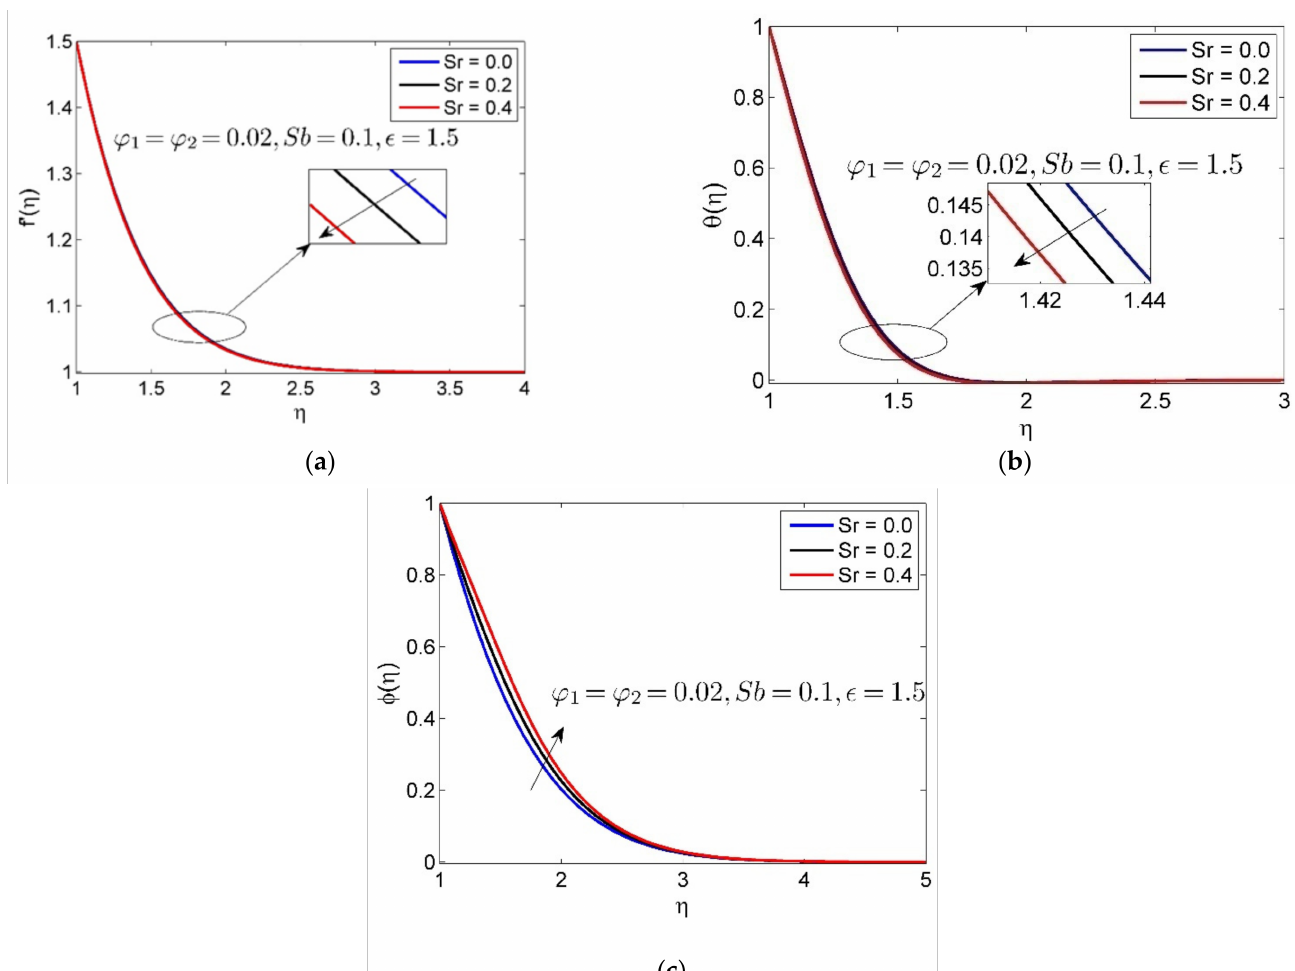
Figure 4. Influences of Sr on f ( η ) and θ ( η ) and φ ( η ) .